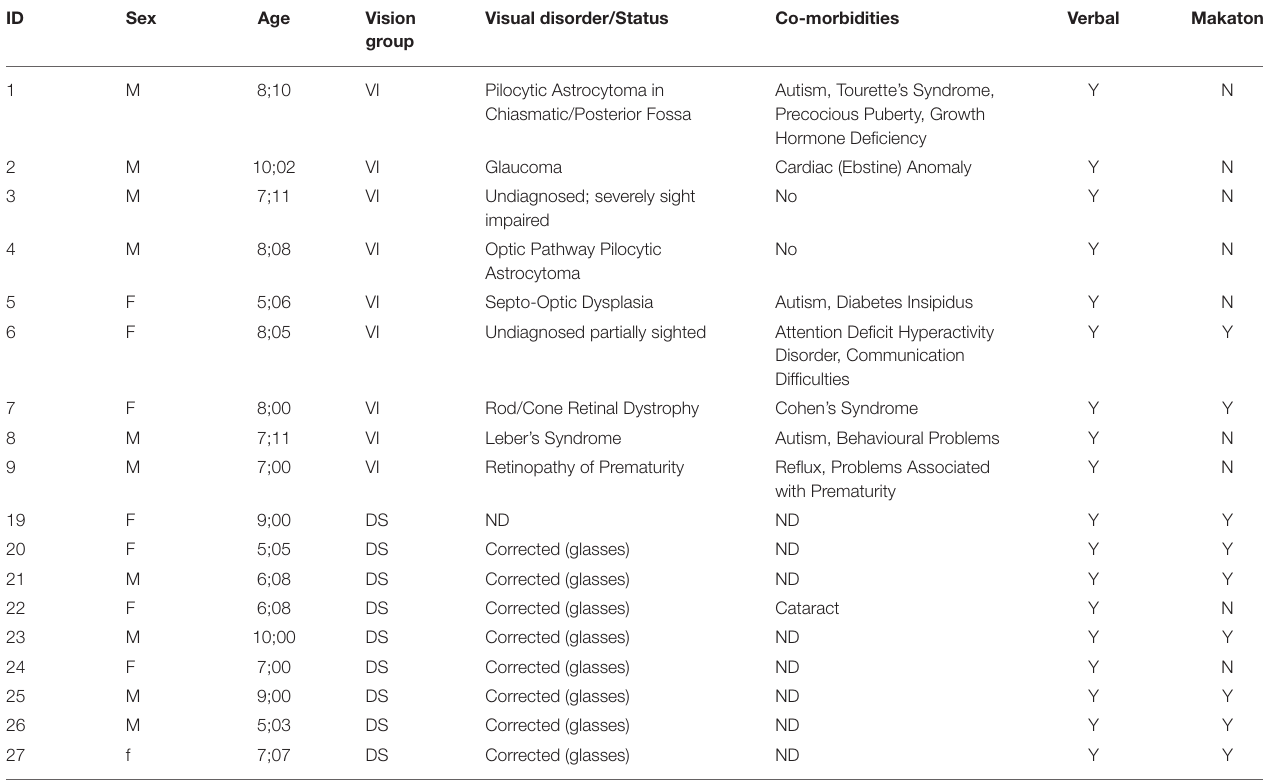
TABLE 3 | Characteristics of children with vision impairment and children with Down syndrome.